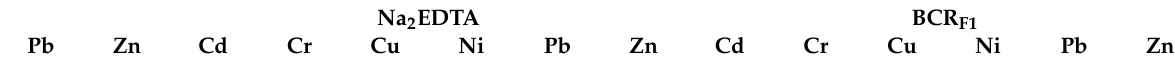
Table 3. Analysis of the correlation between the contents of bioavailable forms ( p ≤